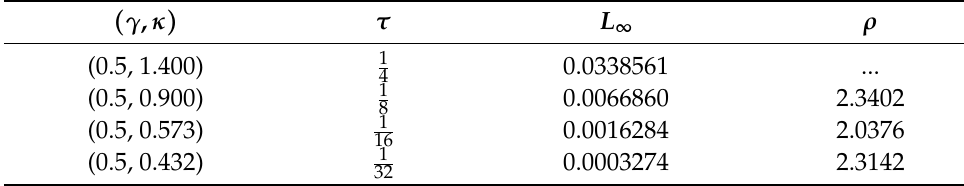
Table 4. The L ∞ error norm and order of convergence ρ of Example 1 when ˜ M = 160.